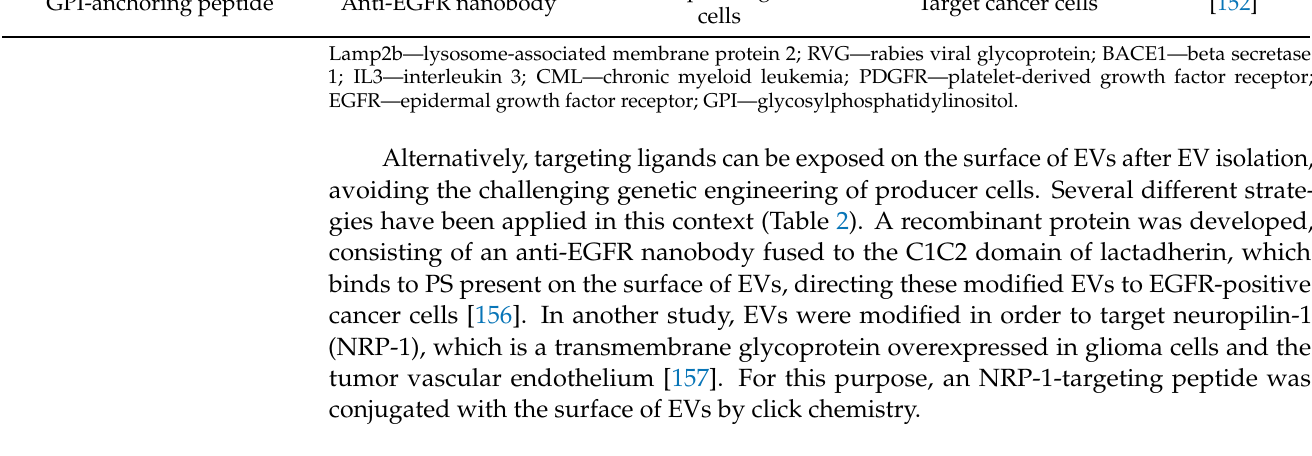
Table 2. Overview of strategies to engineer extracellular vesicles (EVs) targeting by anchoring a targeting moiety to EVs after its production and